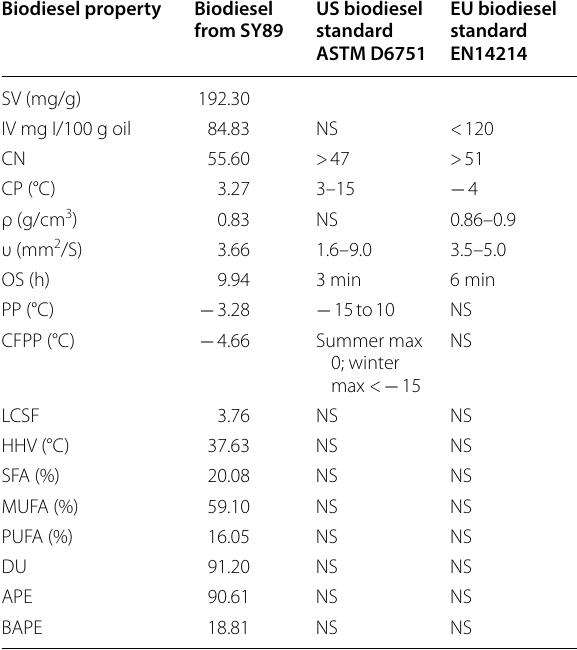
Table 2 Selected physico-chemical properties of biodiesel produced from R. kratochvilovae SY89 grown on molasses compared to standard biodiesel specifications Biodiesel